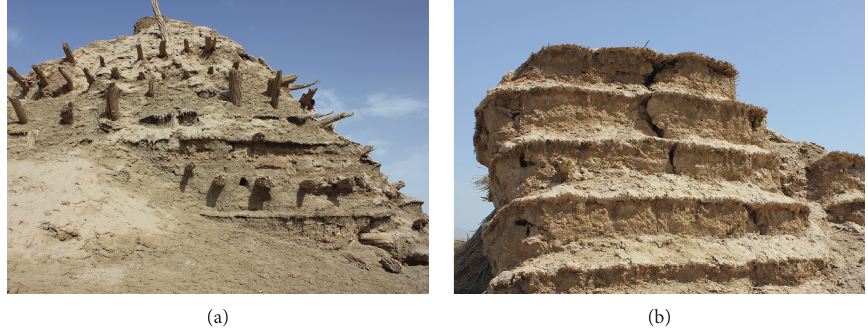
Figure 9: Remaining wooden structures in earthen sites in arid regions. (a) Log skeletons. (b) Plant interlayers.